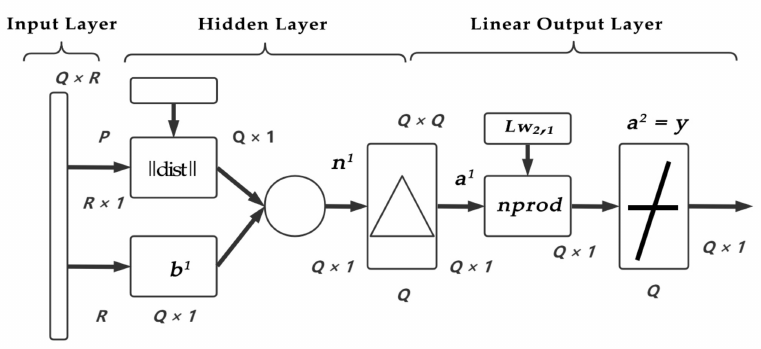
Figure 8. GRNN model prediction flow